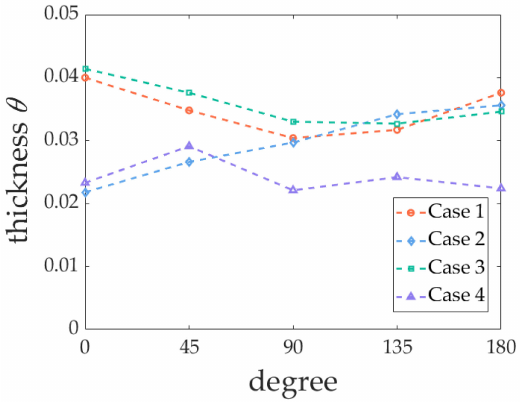
Figure 5. The variation of the momentum thickness θ along the channel